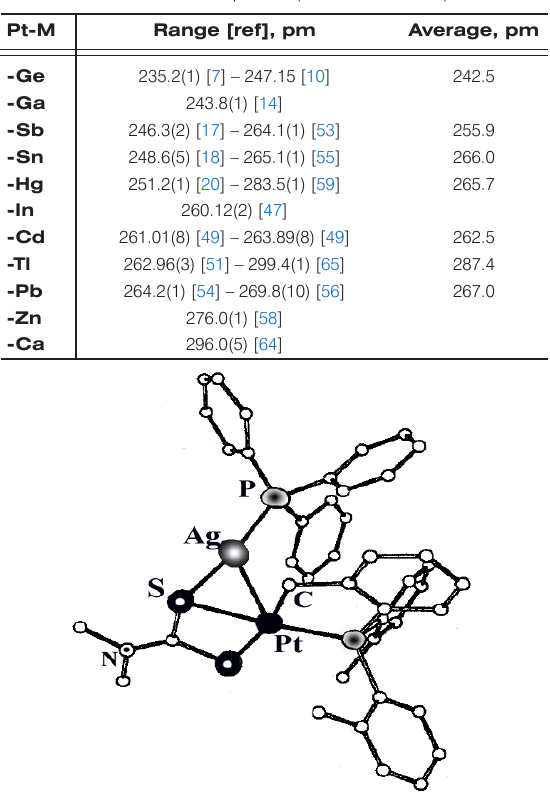
CNMe )Ag(PPh 2 2 3